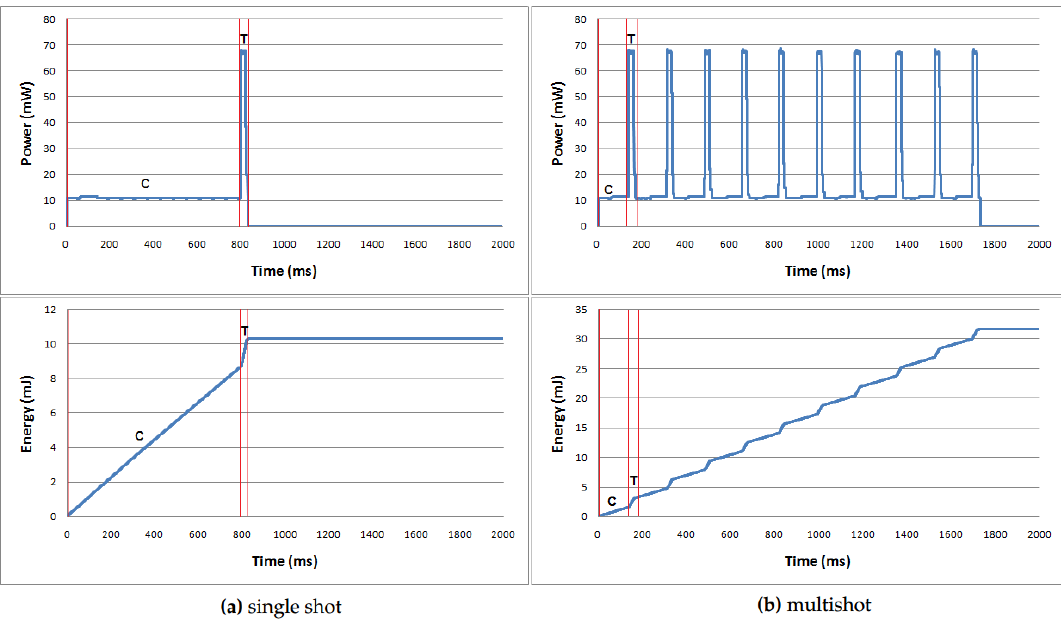
Figure 4. Power and energy comparison between single shot and multishot on the TemperatureMin dataset.